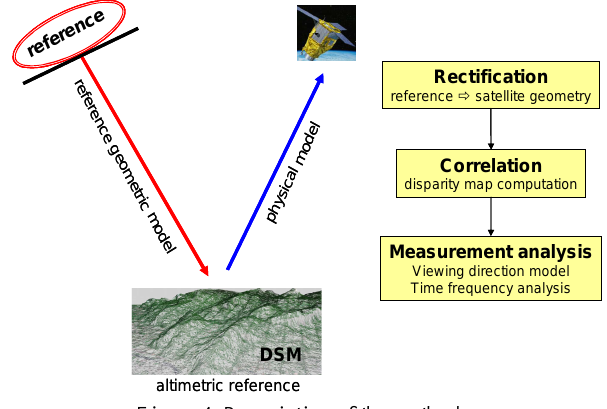
Figure 4: Description of the method